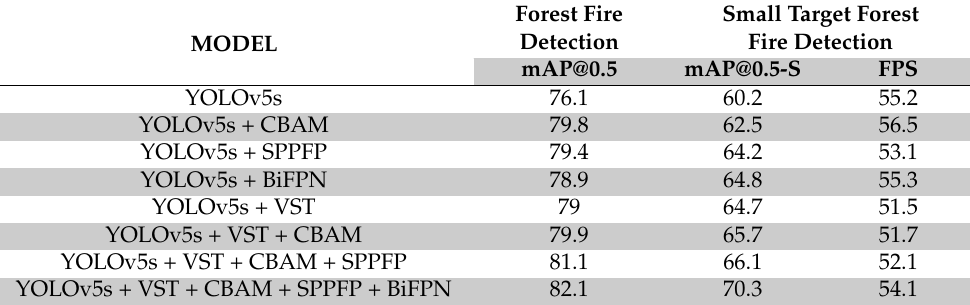
Table 5. The data of the ablation